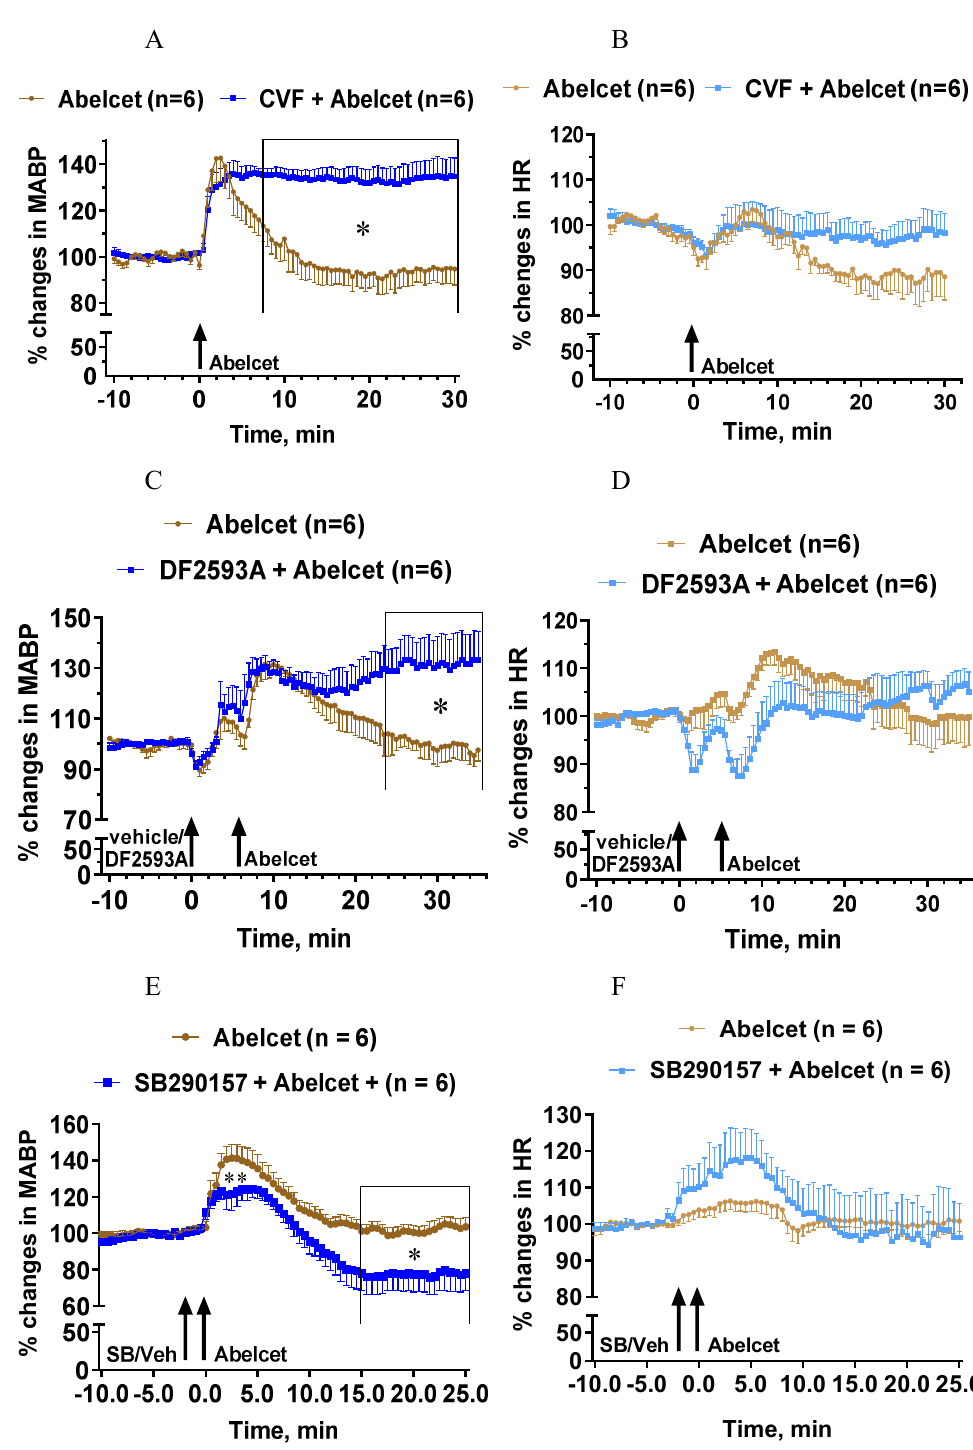
Figure 2. Effects of complement depletion with cobra venom factor (CVF, n = 6) and treatment with DF2593A (n = 6; C3a receptor antagonist) and SB290157 (C5a receptor antagonists; n = 6) on Abelcet- induced MABP and HR changes in anesthetized NMRI mice. The time of treatment with DF2593A, SB290157, or their vehicle and Abelcet injection is indicated by arrows. CVF was administered 18 and 2 h before anesthesia at doses of 30 and 100 U/kg, respectively, in a volume of 10 mL/kg. ( A , C , E ) Mean arterial blood pressure (MABP); ( B , D , F ) heart rate (HR). ( A , B ) Complement depletion with CVF; ( C , D ) treatment with DF2593A; ( E , F ) treatment with SB290157. SB: SB290157; Veh: vehicle. * p < 0.05. Vehicle- and CVF- or drug-treated groups were compared using two-way ANOVA for re- peated measurements followed by Dunnett’s multiple comparison tests. Complement depletion with CVF lengthened the increase in MABP from min 8 after Abelcet administration, but did not